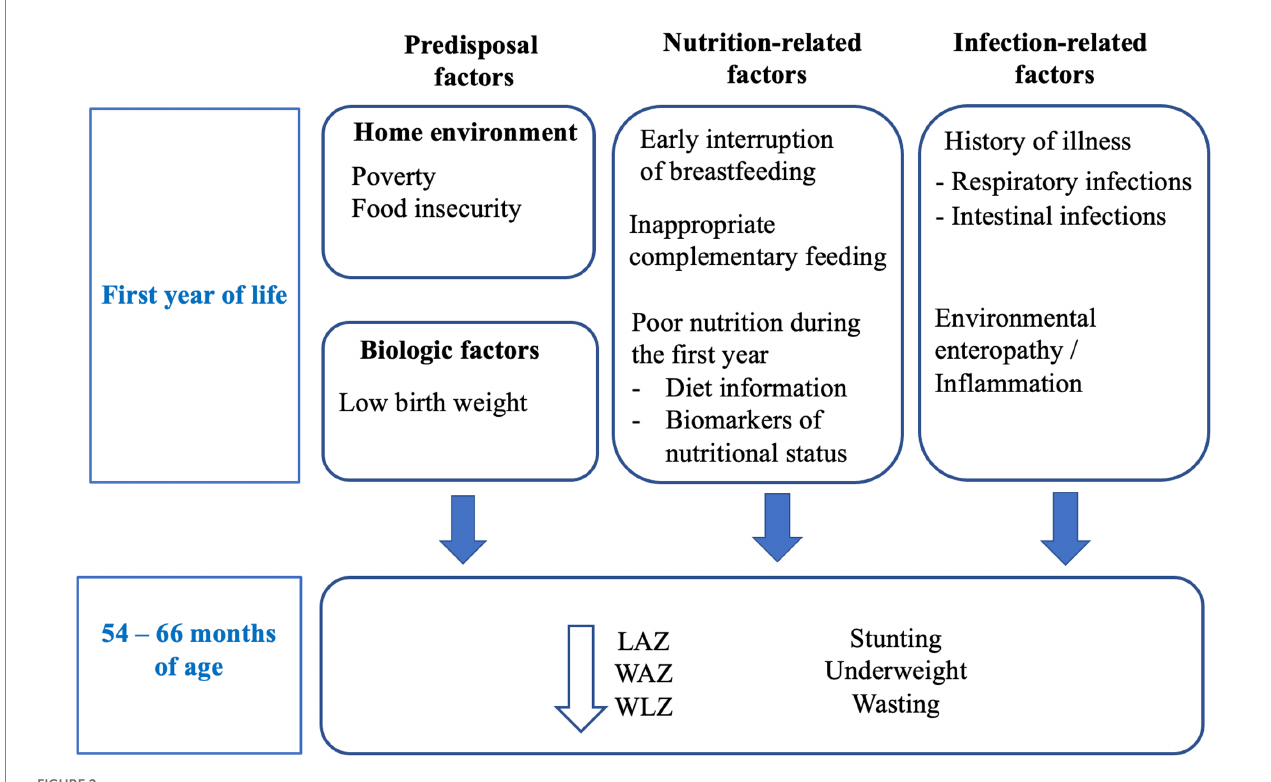
FIGURE 2 Conceptual framework: Known predictors of growth impairment include biological and environmental factors, nutrition-related factors, and infection- related factors. We hypothesize that adverse factors during the first year of life will be associated with indicators of growth at 54–66 months of